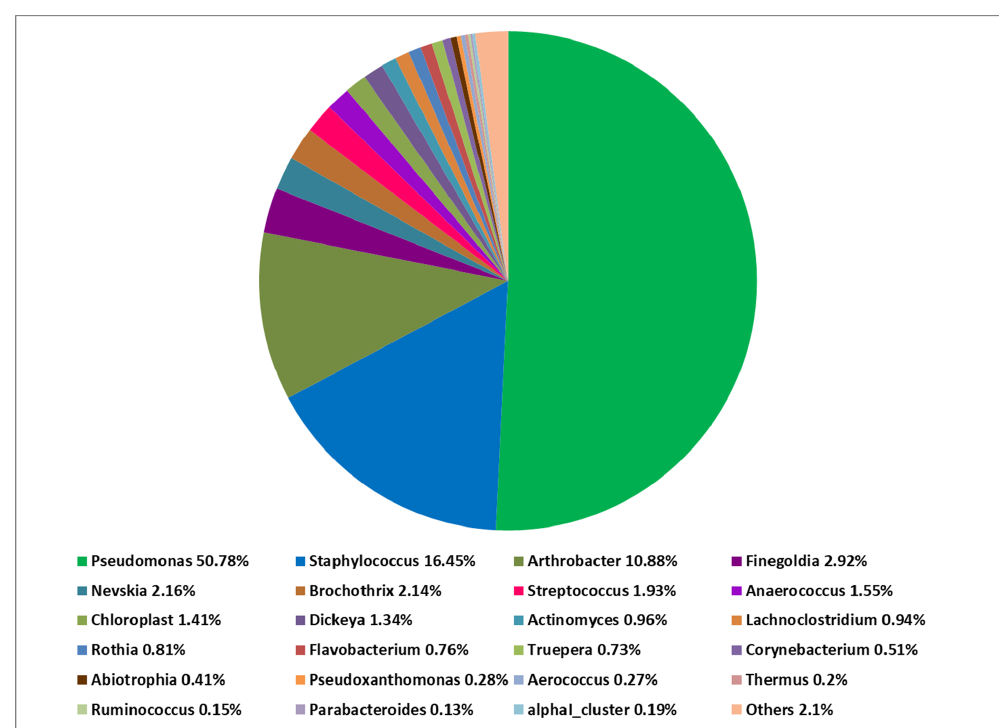
Figure 4. Total composition of the cutaneous bacteria microbiome at the genus level in healthy vol- unteers (HV).